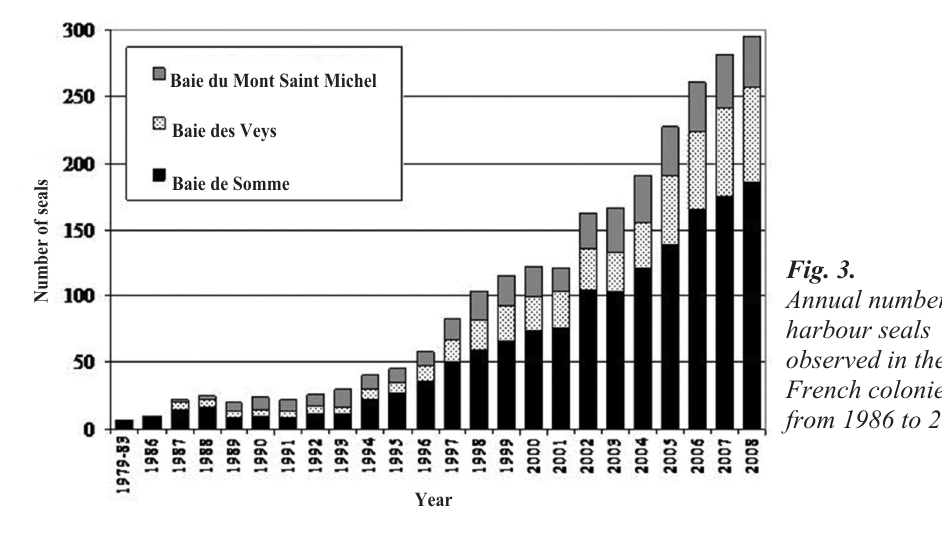
Fig. 3. Annual number of harbour seals observed in the three French colonies from 1986 to 2008.